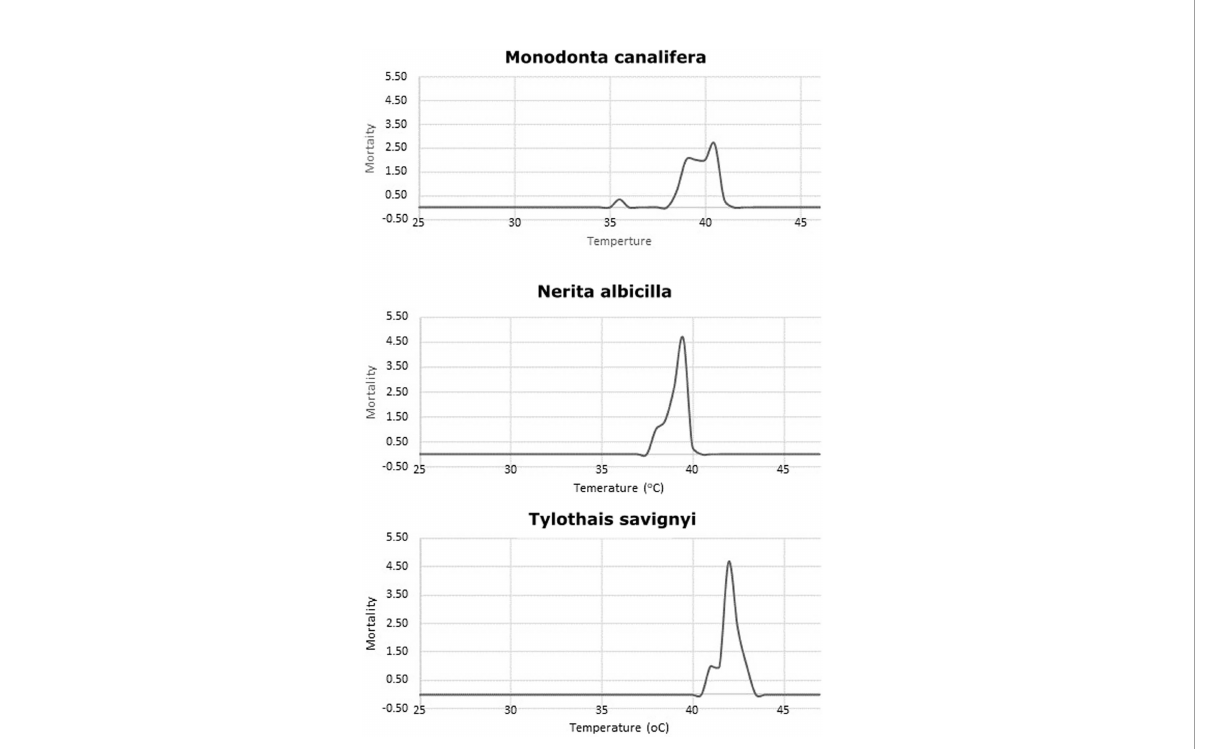
FIGURE 1 CT max rise of temperature to determine the maximum critical temperature where the activities of organisms